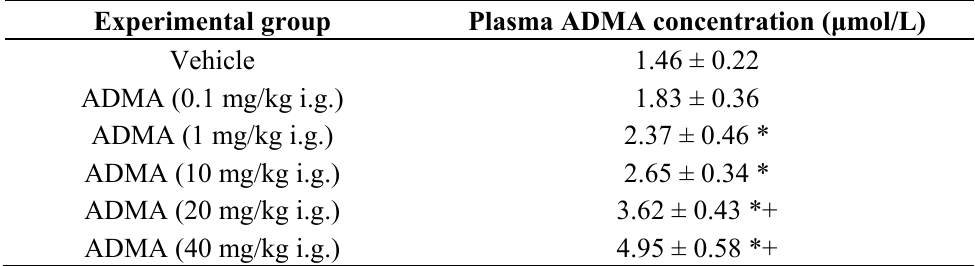
Table 1. Effect of pretreatment with vehicle (saline) or ADMA administered i.g. in graded doses ranging from 0.1 up to 40 mg/kg i.g. on the plasma levels of ADMA in rats exposed to 3.5 h of ischemia/reperfusion. Mean ± S.E.M of 6 rats per each group. An asterisk indicates a significant ( p < 0.05) increase as compared with vehicle-control. An asterisk and cross indicate a significant difference ( p < 0.05) when compared with the vehicle and ADMA applied in doses 1 or 10 mg/kg.